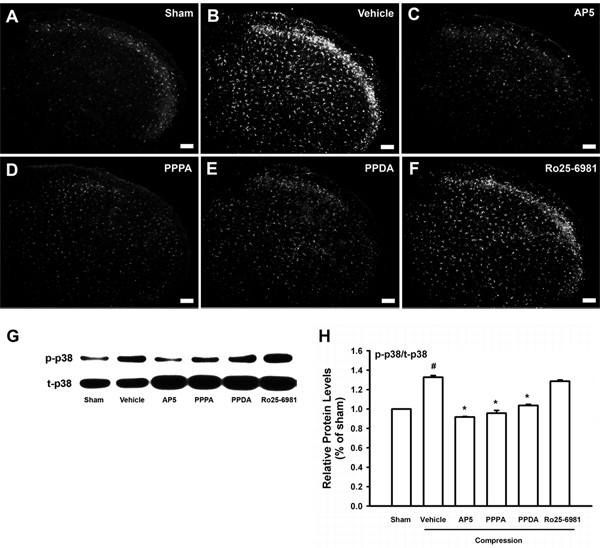
The effects of NR2 subunit antagonists on the expression of p-p38 MAPK. Changes in the expression of p-p38 MAPK in medullary dorsal horn of rats with compression of the trigeminal of nerve root following the administration of NR2 subunit antagonists (n = 5 in each treatment group). The intracisternal administration of vehicle did not affect p-p38 MAPK levels caused by compression of the trigeminal nerve root (B). However, the intracisternal administration of AP5 (10 μg), PPPA (1 μg), or PPDA (5 μg) decreased p-p38 MAPK expression in the medullary dorsal horn (C-E). However, Ro25-6981 (100 μg) did not affect p-p38 MAPK levels (F). Western blot analyses further confirmed that the upregulation of p-p38 MAPK was significantly suppressed by all NR2 subunit antagonists tested except for Ro25-6981 (G, H). The total p38 (t-p38) levels were used as the loading control. Scale bar, 50 μm. #P < 0.05, compared with the sham-treated group, *P < 0.05, compared with the vehicle-treated group.